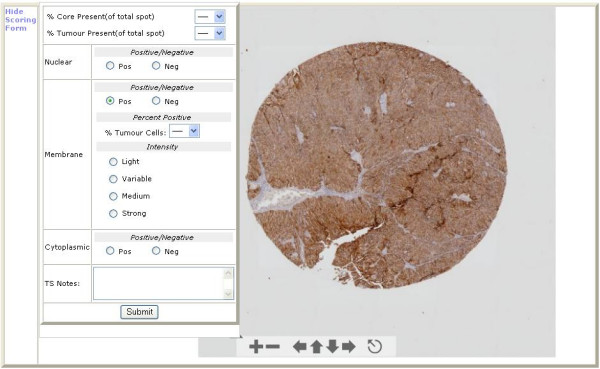
Scoring form presented to users within the VTM interface. Results can be entered into the scoring form on the left, the image can be magnified and scrolling is possible via the controls provided.